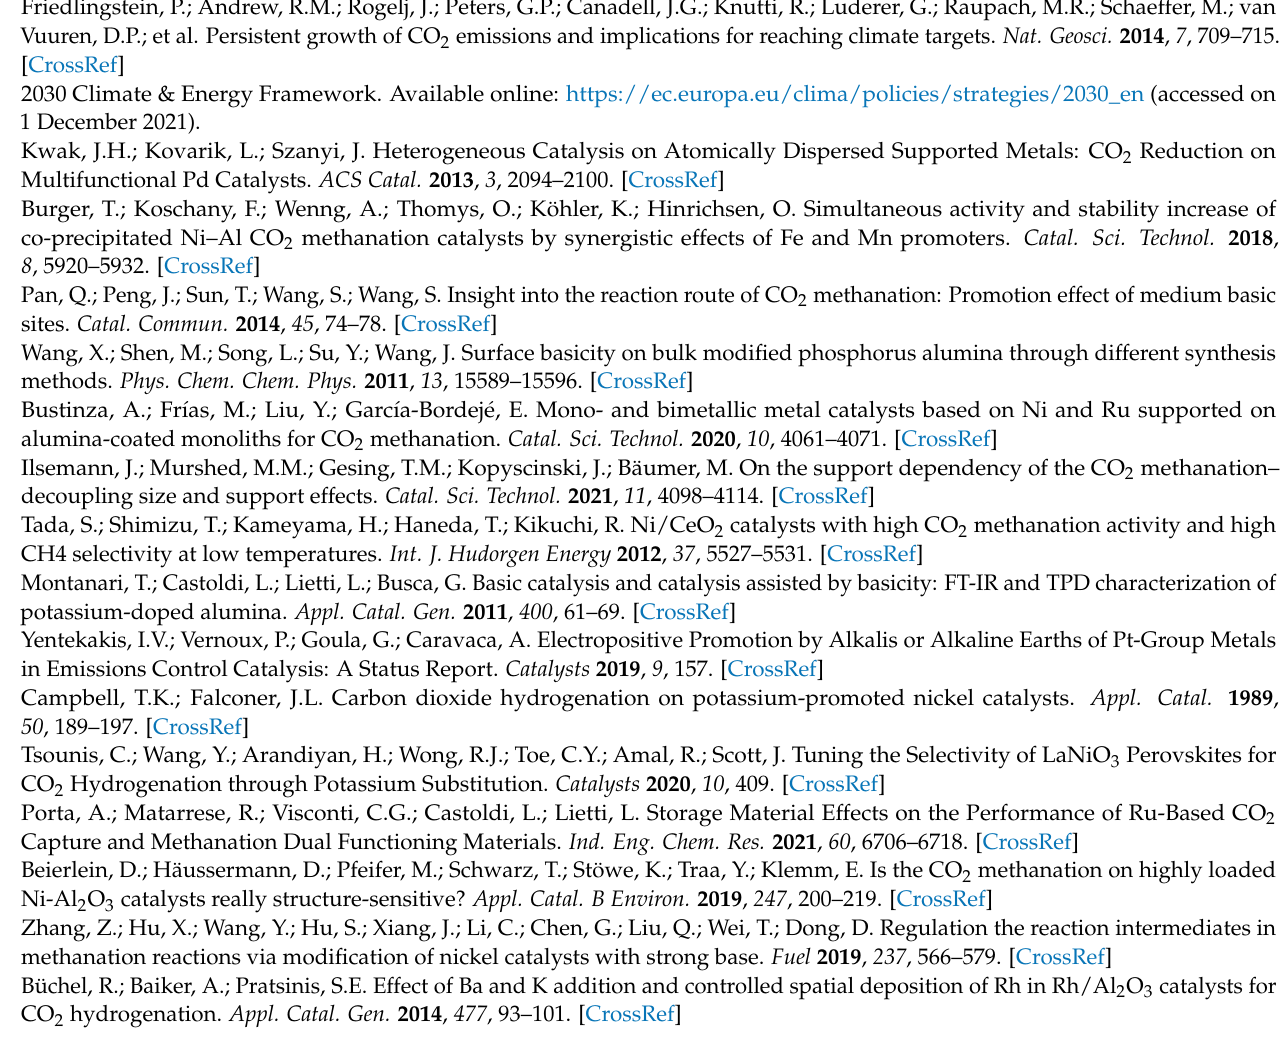
Figure S2: Representative XEDS-mapping in STEM mode for (10%K)15%Ni/Al, Figure S3: